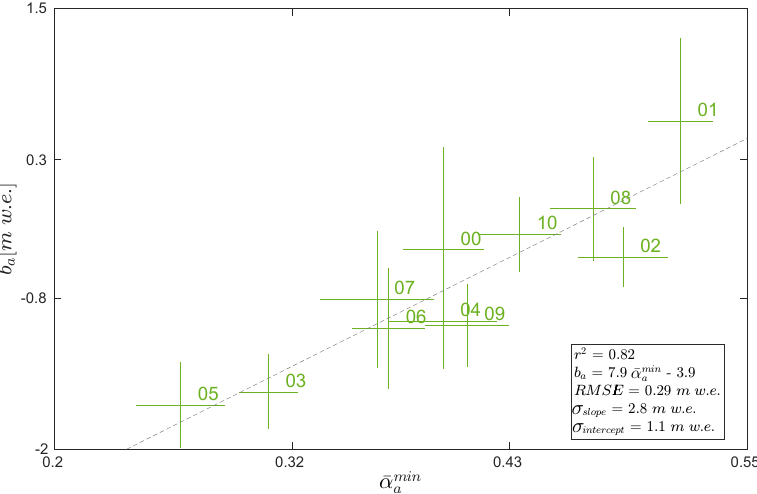
Figure 6. Annual SMB as a function of the MODIS-retrieved summer minimum glacier-wide average albedo for Blanc Glacier. Error bars show the dispersion of the available annual SMB data and the quadratic sum of the systematic errors made on each albedo measurement. The thin dashed grey line illustrates the line of best fit, along with regression coefficients and